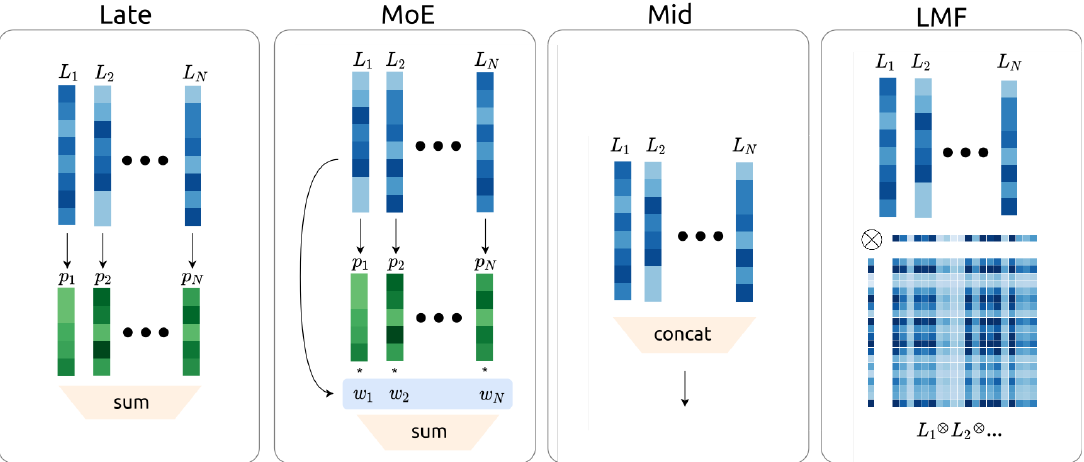
Figure 3. Multi-modal fusion architectures used in experiments. From left: Late Fusion (Late), Mixture of Experts (MoE), Intermediate Fusion (Mid), Low-rank Modality Fusion (LMF). Arrows represent the transformations realized with the use of neural networks, while L i , p i , w i denotes the latent vector, predictions and trainable weight associated with i -th